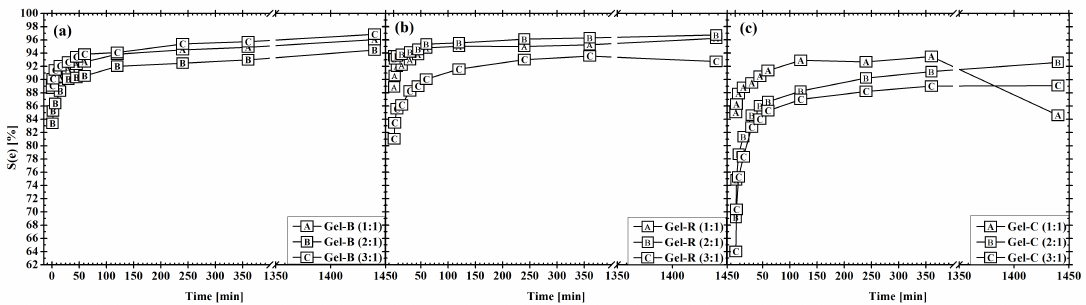
Figure 4. Swelling of Gel-based hydrogels: ( a ) Gel-B, ( b ) Gel-R, and ( c ) Gel-C.